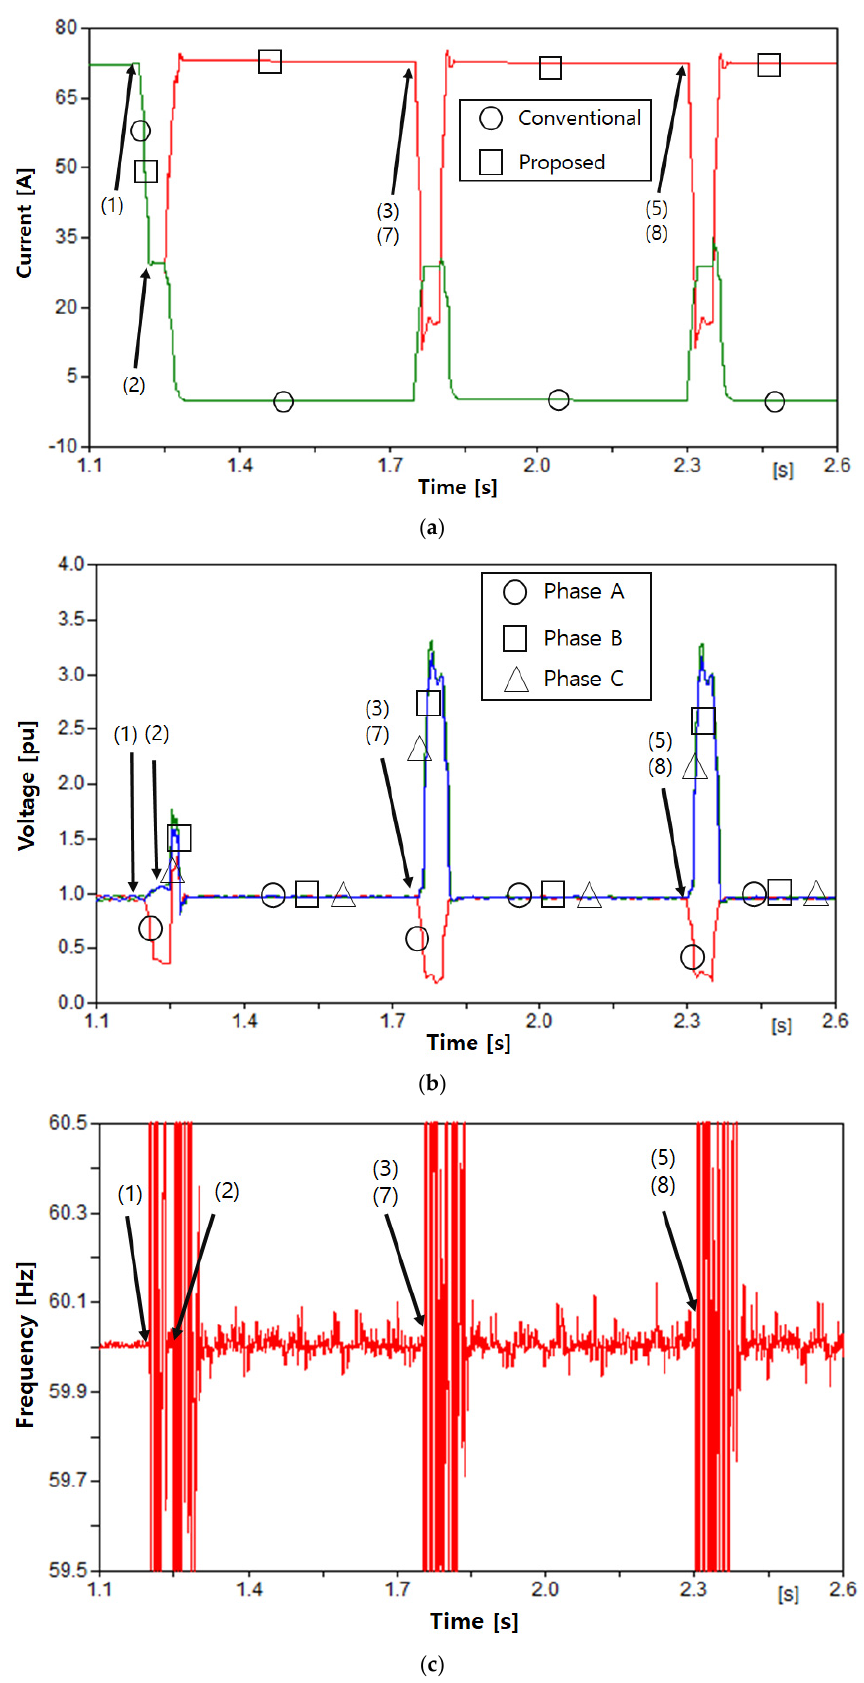
Figure 12. Simulation results of Case 5: ( a ) current flowing to Load 2; ( b ) voltage at Bus 3; ( c ) frequency at Bus 3.